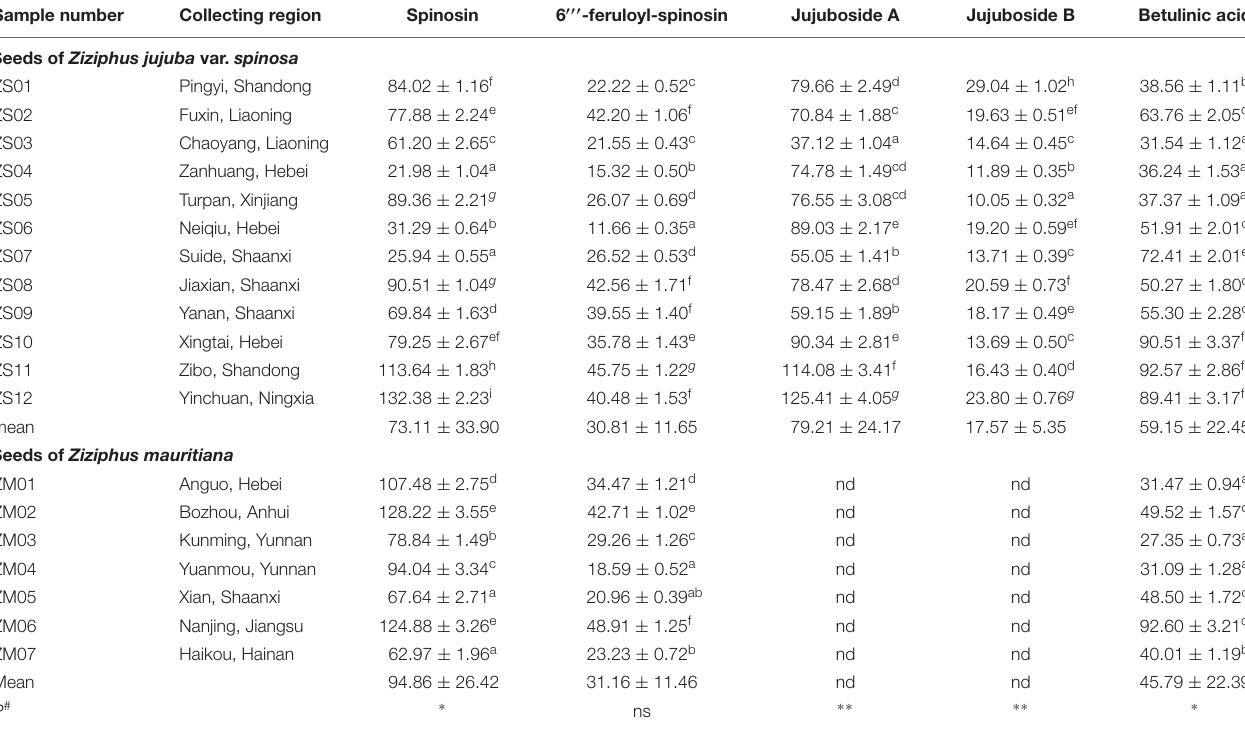
TABLE 1 | Contents of flavonoids and triterpenoids (mg/100 g) in the seeds of Ziziphus jujuba var. spinosa and Z. mauritiana (mean ± SD). Sample number Collecting region Spinosin 6 (cid:48)(cid:48)(cid:48) -feruloyl-spinosin Jujuboside A Jujuboside B Betulinic